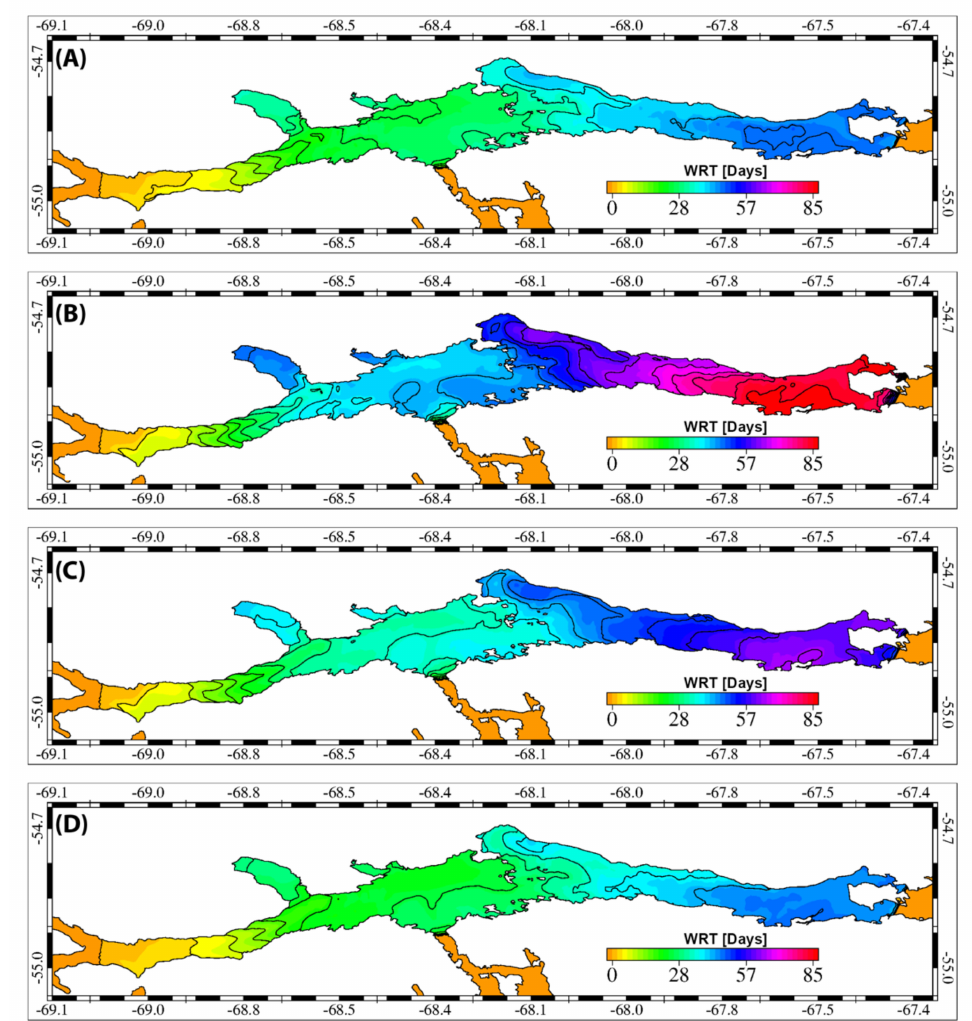
Figure 7. Vertically averaged water residence times computed for summer ( A ), autumn ( B ), winter ( C ) and spring ( D